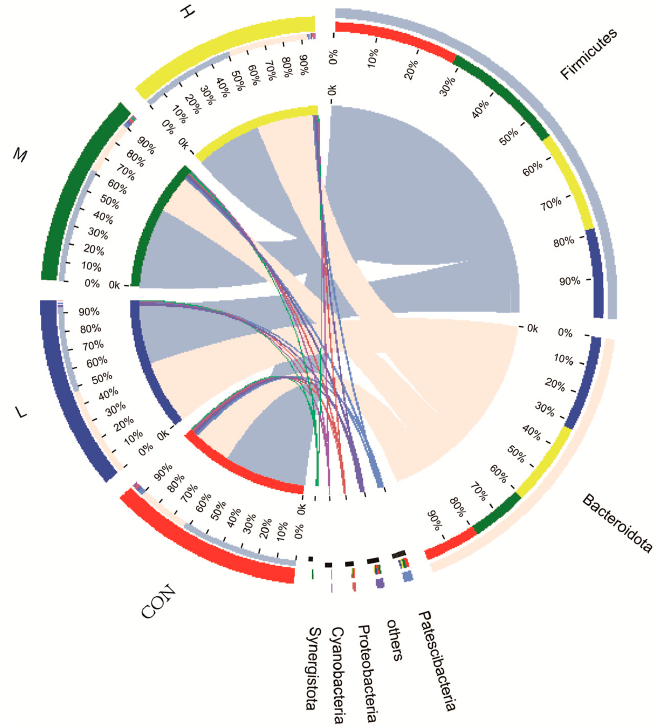
Figure 2. Composition of rumen microbial phyla in lambs. CON, L, M and H represent the substi- tution of 0, 20, 40 and 60% of maize silage with mulberry silage, respectively. A total of 327 taxa were found in the analysis at the genera level of the rumen